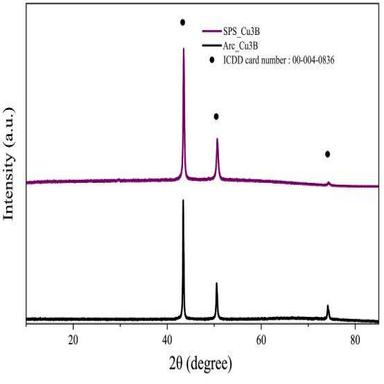
XRD spectra of the SPS_Cu3B and Arc_Cu3B samples. The three marked peaks are related to the FCC crystal lattice of copper.